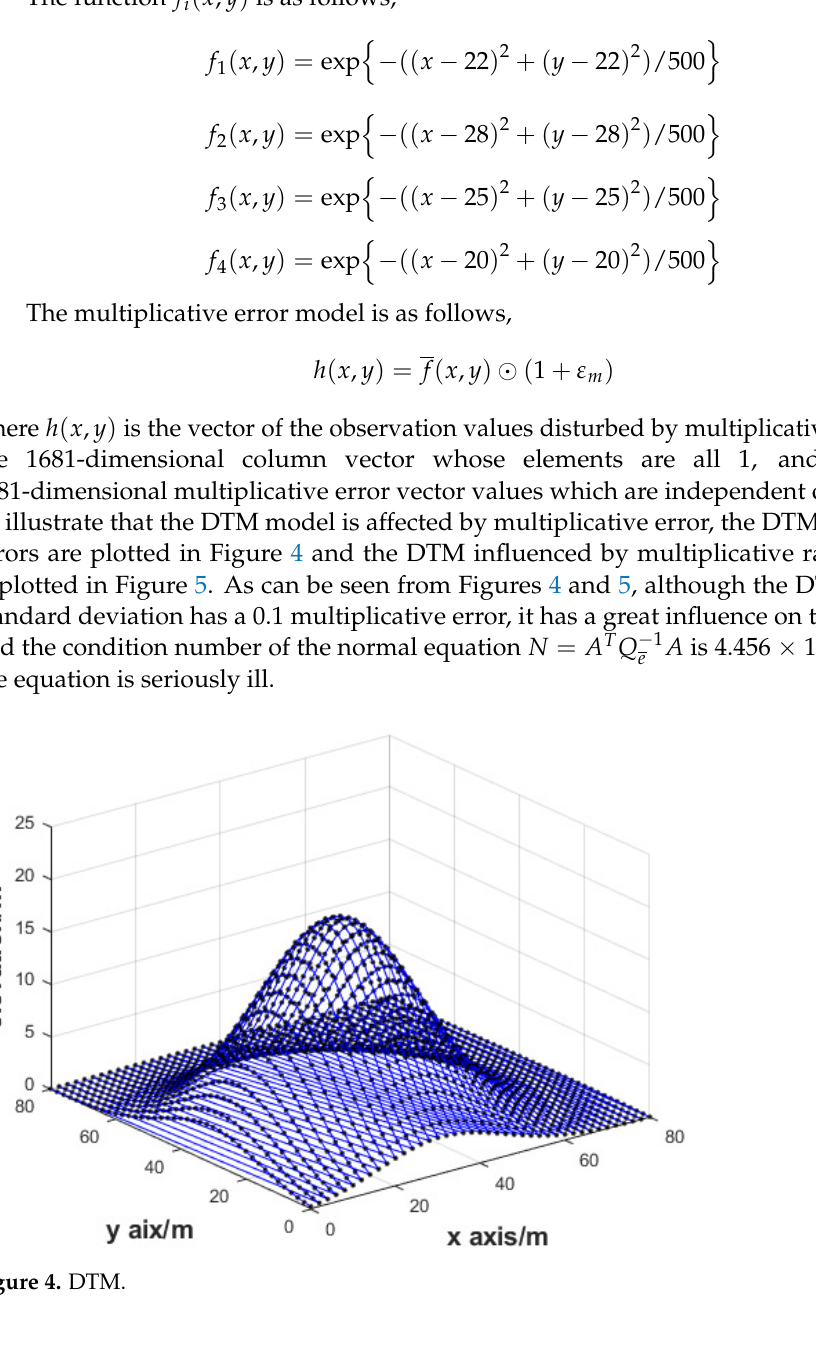
Figure 5. DTM with multiplicative error. 3.2. Actual Experiment 3.2.1. Actual Experiment I (I) Experiment 1 The Lashagou NO. 3 landslide was a loess landslide located at Lashagou village, Jishishan county, Gansu province, China. Its geographical coordinates are 35° 35 ′ 23 ″ E, 102° 57 ′ 12 ″ N. It is in the transition zone between the Tibetan Plateau and the Loess Plat- eau, which is typical of an excavation-related shallow loess engineering landslide [58,59]. The main stratum of the landslide is Holocene residual slope silty clay and the main stra- tum of the slide bed is middle and lower Pleistocene fluvial and lacustrine maroon silty clay. The central width of the slide body is 60–100 m, the axial length is 80–130 m, the area is about 25,000 m 2 , the thickness is 3–8 m, and the volume is about 150,000 cubic meters, belonging to the middle-shallow medium and small-sized landslide groups. The rear wall of the landslide was 0.2–0.4 m high, the natural slope was 15°, and the main slide direction was 85°. The front slope of this landslide group is mainly damaged by slime in the surface 1–3 m, but the lower soil is relatively stable, and the back edge of the landslide group is in the shape of an armchair and a gentle arc, which belongs to the traction cohesive soil landslide group. The optical remote sensing imagery of the landslide is shown in Figure